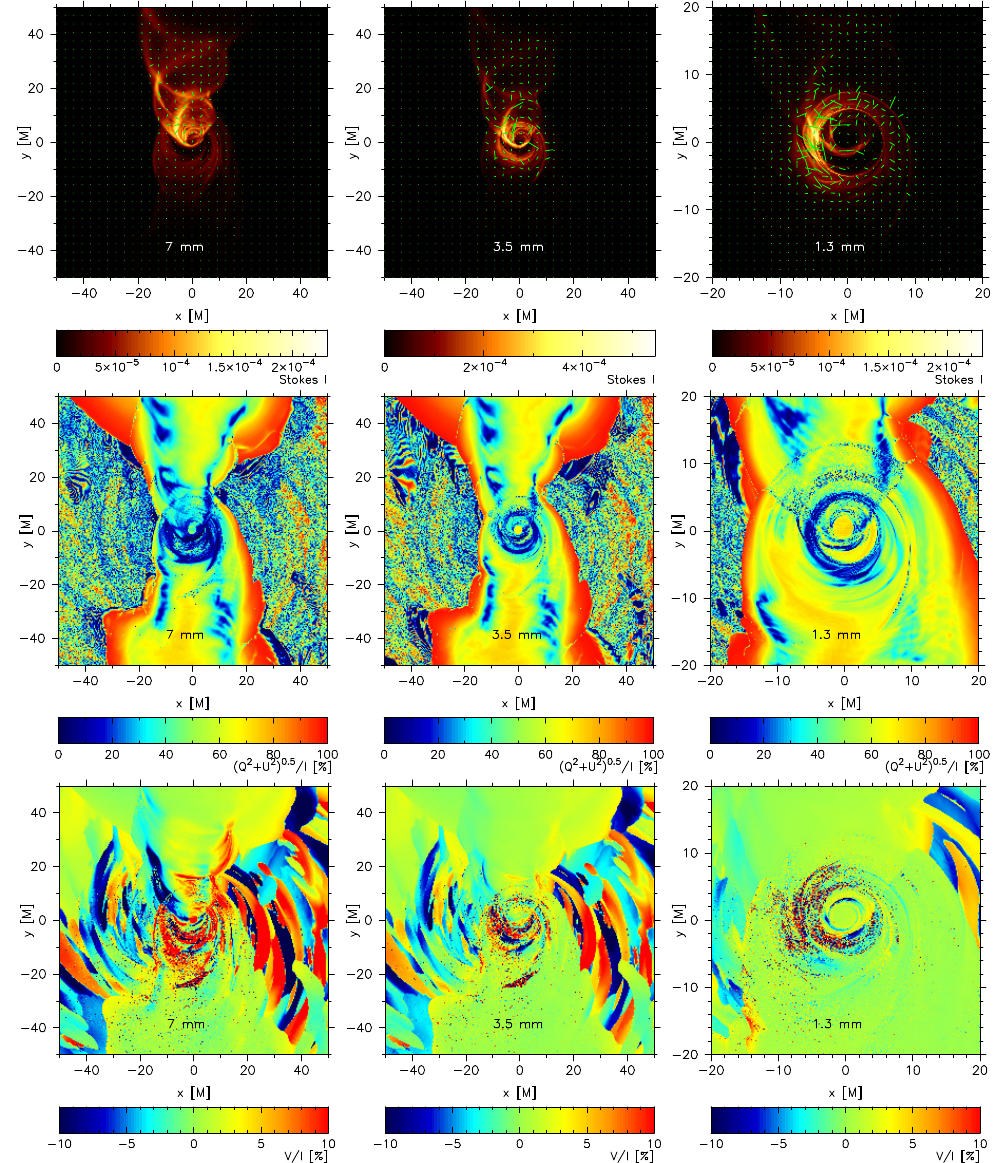
Figure 1. From left to right, the panels show the appearance of the GRMHD model of a relativistic jet in polarized light at three wavelengths at which the M87 core jet is typically observed. The viewing angle is i = 20 ◦ off the black hole spin axis, and the polarized radiative transfer calculations are carried out within r < 50 GM / c 2 as beyond that regions the models are not relaxed. Notice that the rightmost panels display the image of the model just near the black hole event horizon. Top panels: the intensity of radiation (the same total intensity maps are published in [16]) overplotted with polarization ticks. (cid:112) Q 2 + U 2 . Middle panels: the corresponding maps The length of each tick is proportional to the local of the linear polarization degree. Bottom panels: maps of the circular polarization degree. The 1.3 mm image in the topright panel has been published in